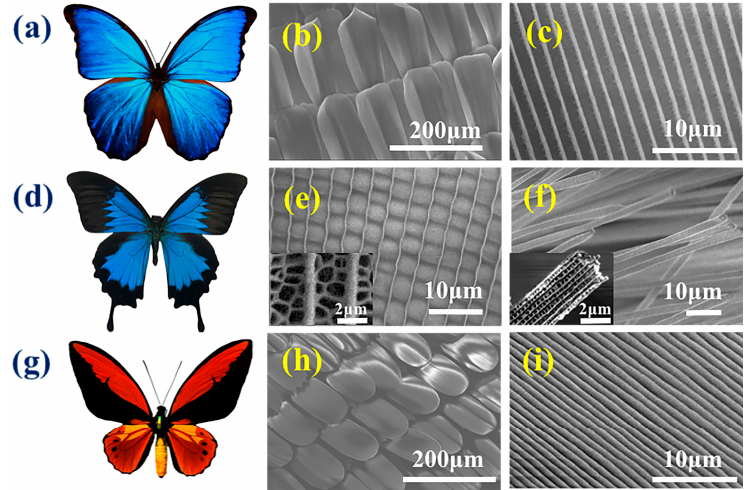
Figure 1. ( a ) Optical image of M. menelaus ; ( b , c ) Scanning Electron Microscope (SEM) image of the nanostructure of the wing under different magnification. ( d ) Optical image of P. u. telegonus ; ( e ) SEM image of the nanostructure of the blue region; the insert in ( e ) is the high magnification of SEM image; ( f ) SEM image of the nanostructure of the fiber region; and, the insert in ( f ) is the high magnification of SEM image. ( g ) Optical image of O. c. lydius ; ( h , i ) the SEM image of the nanostructure of the wing according to different magnification.